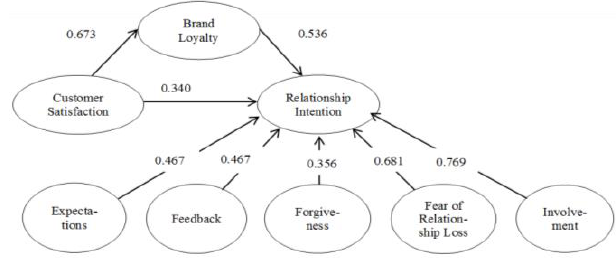
Figure 2: The structural